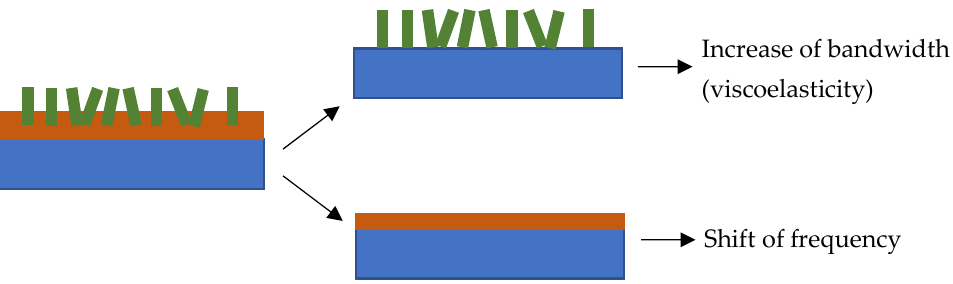
Figure 9. A model describing the morphological composition of the petalous SA layer. The brown layer represents the dense base or matrix component, and the green structure represents the pet- alous pillar.